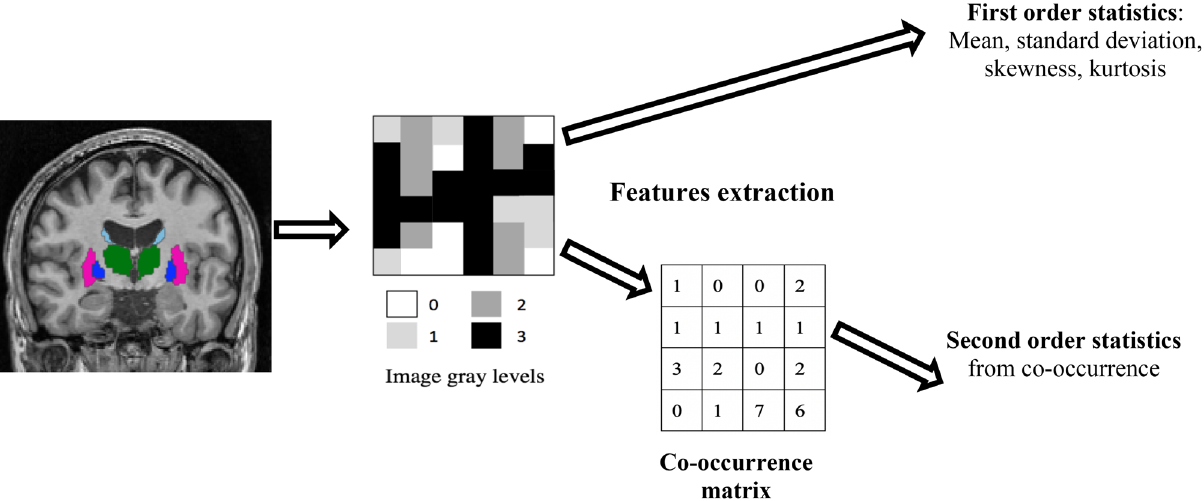
Figure 6. Texture features extraction scheme. For each brain structure represented as a region of interest segmented on the T1w MR images, gray levels variation is captured without taking into account voxels neighbouring using first order statistics and by considering the neighbourhood by converting the gray levels into a co-occurrence matrix and then extracting the second order